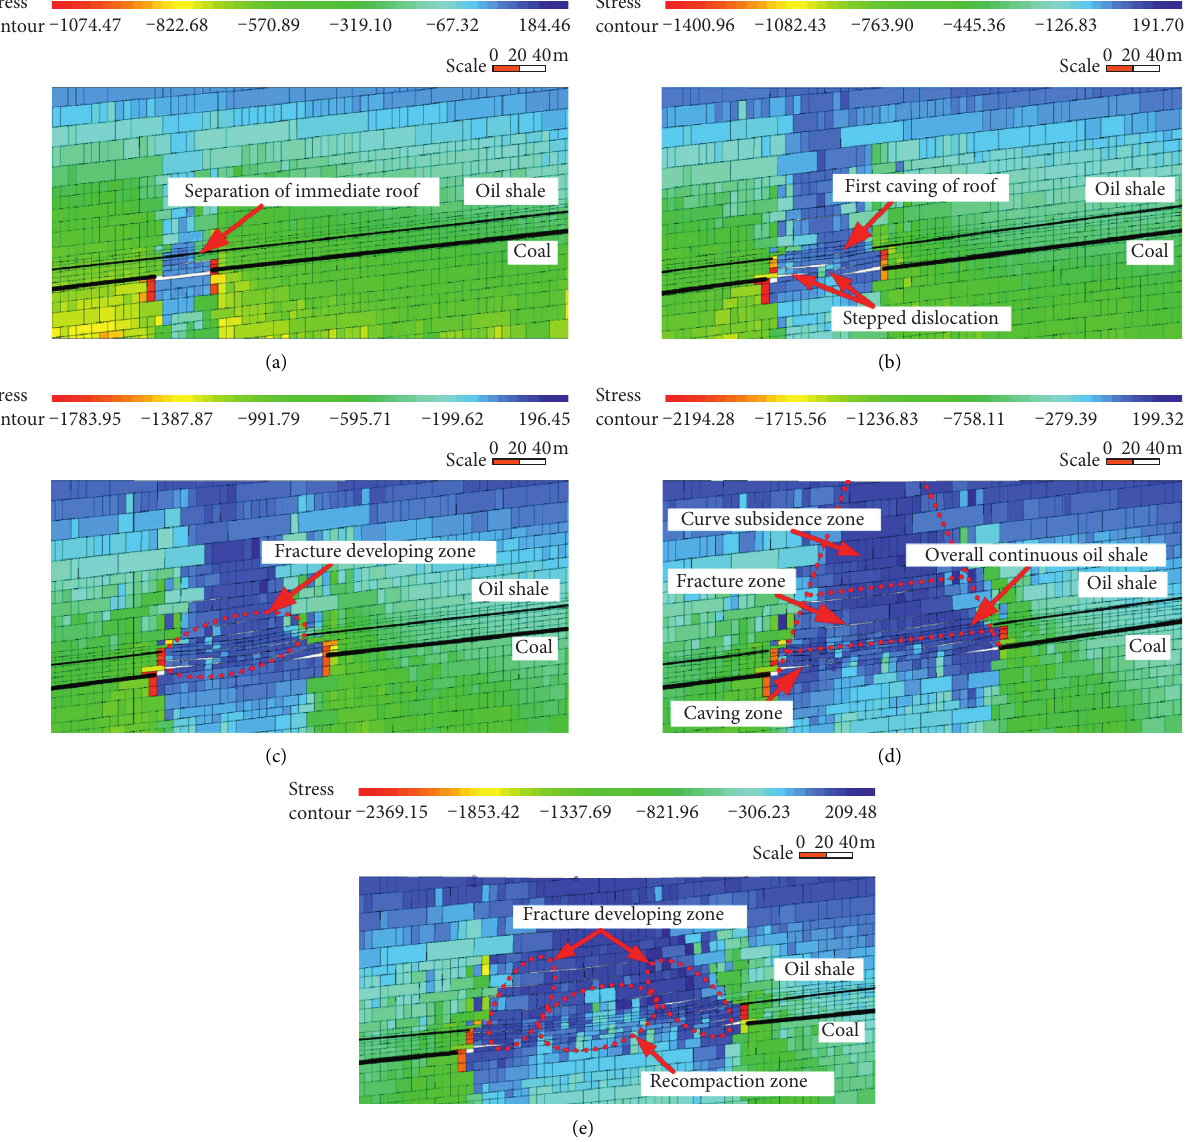
Figure 5: Evolution laws of fracture and stress fields at different advancing stages of coal and oil shale combined mining. (a) 25m. (b) 50m. (c) 75m. (d) 100m. (e)